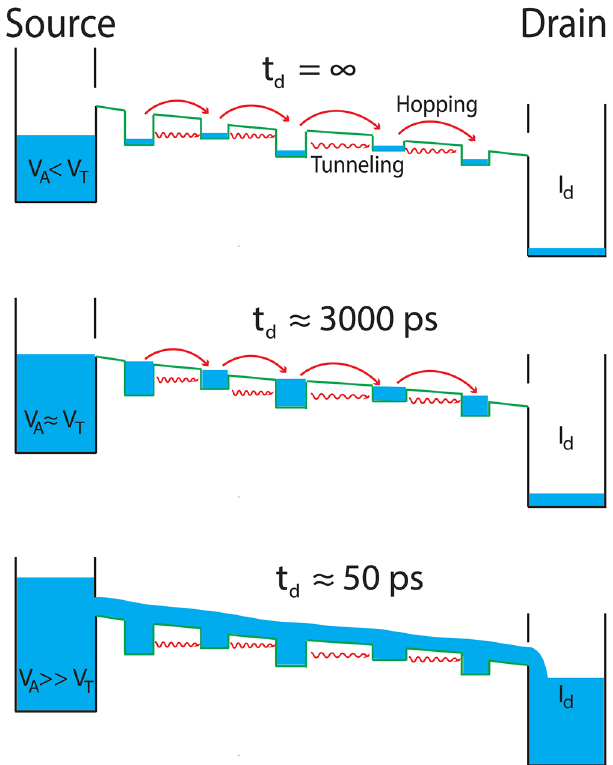
Figure 4. Water filling model for threshold switching in ultra-fast timescale. As V A < V T , carrier transport is limited by a potential barrier caused due to the trap states, and device current is negligible. With V A = V T